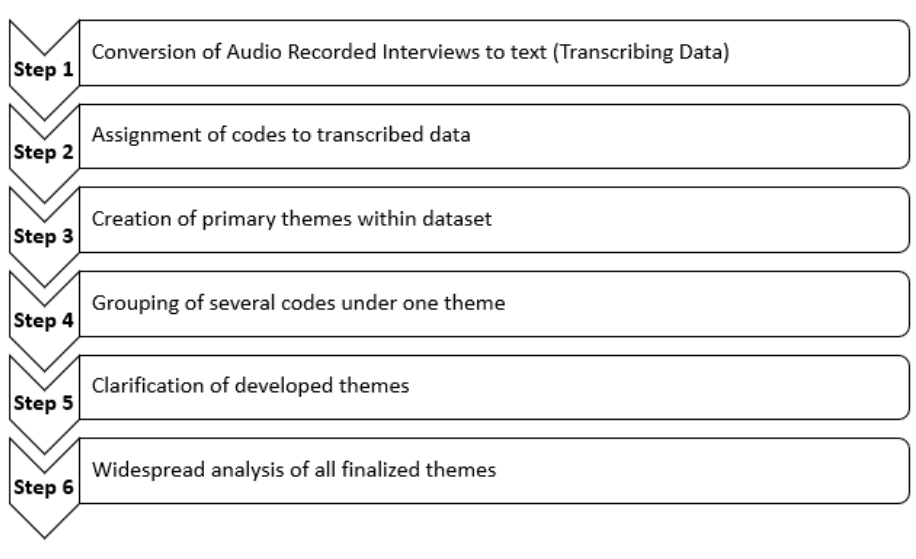
Figure 1: Thematic Analysis of the